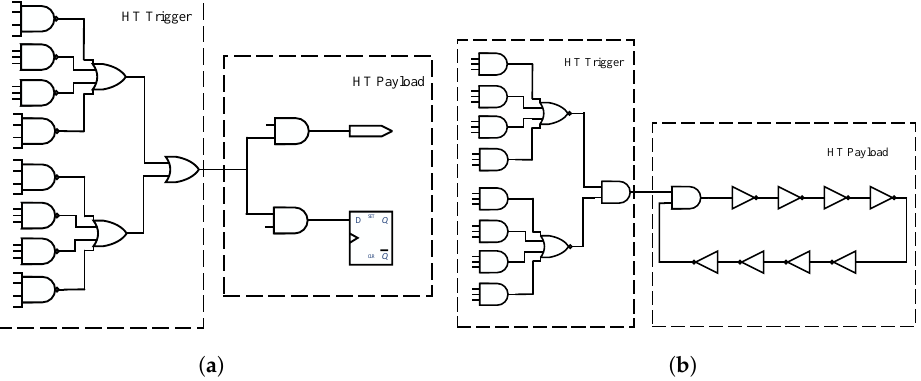
Figure 7. Two categories of Trojan load circuits. ( a ) The load circuit is similar to the normal circuit ( b ) The load circuit contains structure that rarely appeared in both normal circuits and Trojan